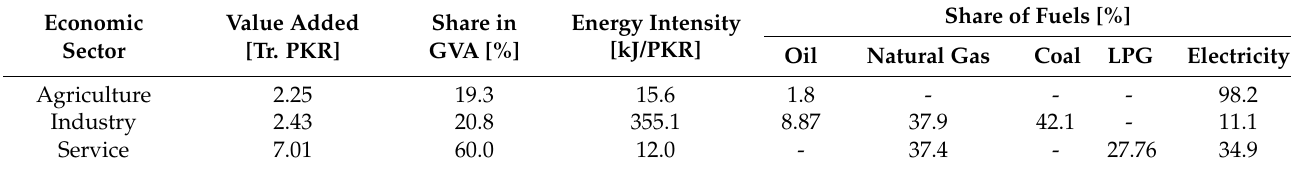
Table 11. Economic sectors details